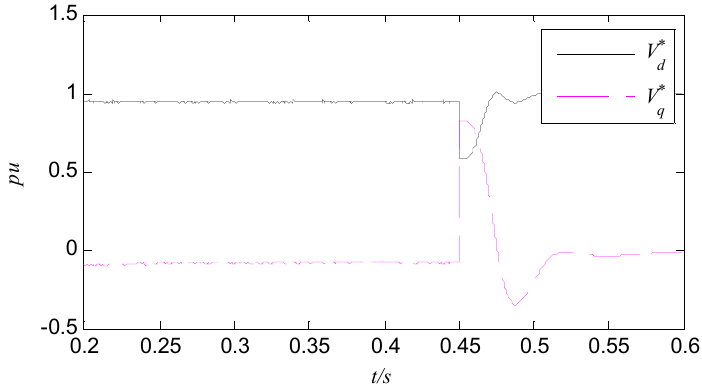
Figure 8. The controller output during islanding process.